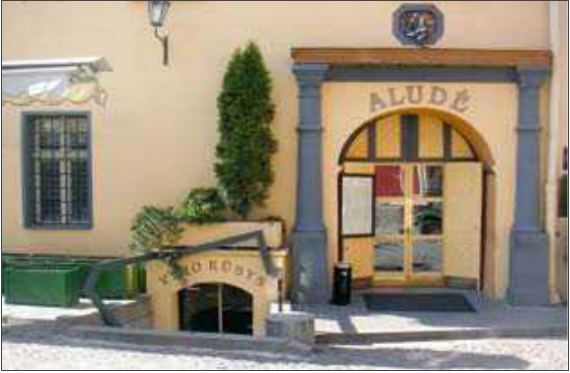
Fig. 4. 16th century portal in Gaonas st